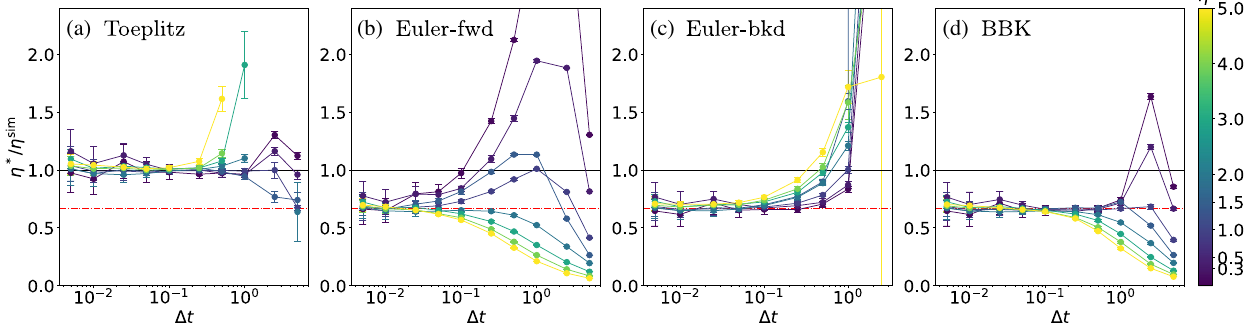
FIG. 7. Accuracy of the different likelihood-based methods in inferring the damping coefficient of the harmonic oscillator, in varying damping regimes: (a) shows the O ð Δ t 3 = 2 Þ Toeplitz method; (b) – (d) show the three O ð Δ t 1 = 2 Þ variants corresponding, respectively, to the Euler-forward, Euler-backward, and BBK schemes. The main features to highlight are the appearance of the 2 = 3 rescaling factor for the O ð Δ t 1 = 2 Þ scheme (red dot-dashed line), compared to the absence of any rescaling for the O ð Δ t 3 = 2 Þ scheme, and the higher stability of the latter with respect to Δ t filtering. Different damping regimes are explored: The sampled values of η sim are indicated in the color bar. The remaining parameters are T ¼ 1 and ω 0 ¼ 1 . Each point is the average of the inference results of ten different trajectories of 5000 points (for any Δ t ). Error bars are taken as 0.95 CI.